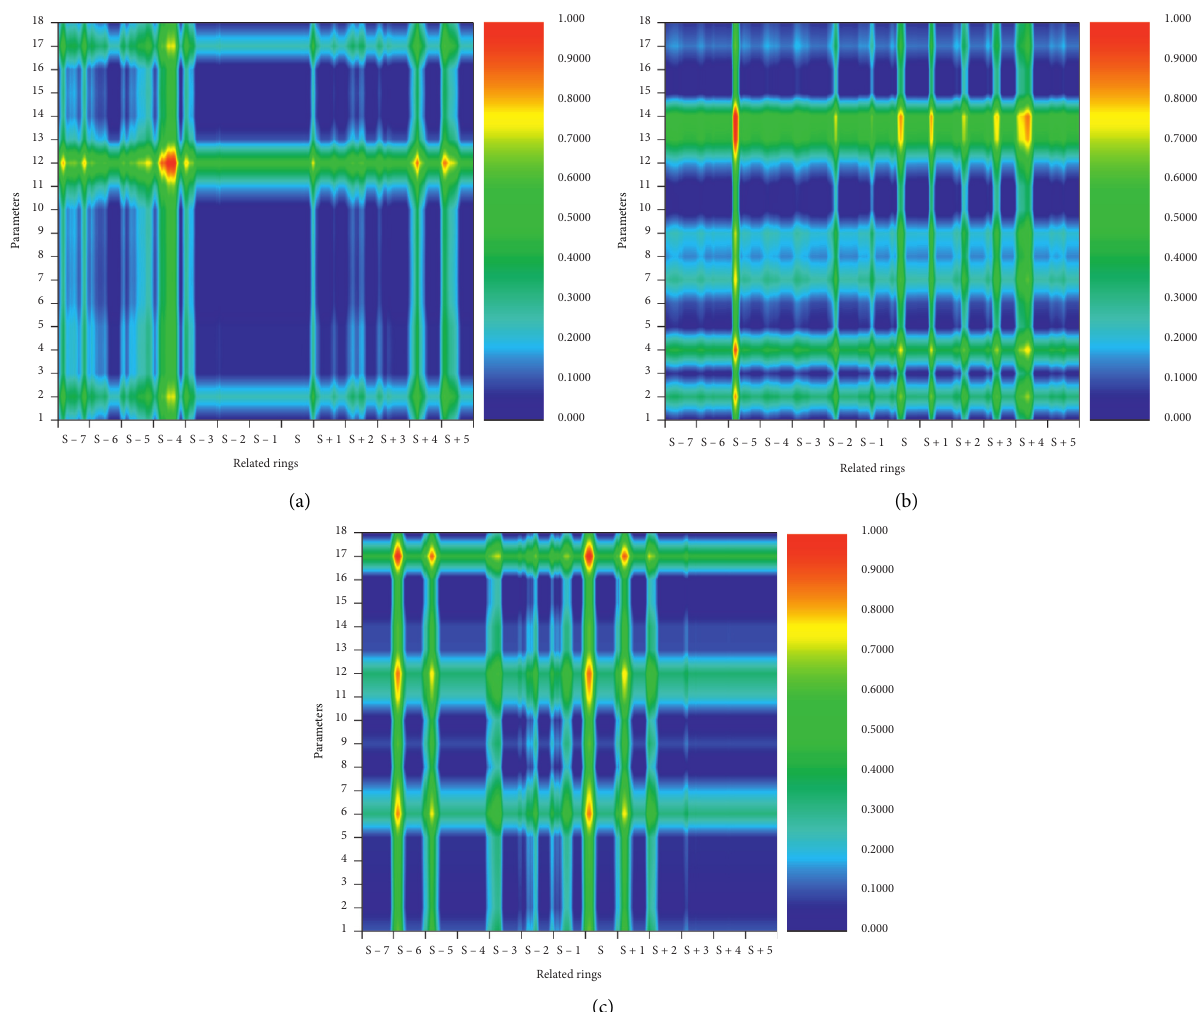
Figure 11: Thermal diagrams showing the contributions made to the different classes. (a) Class I. (b) Class II. (c) Class